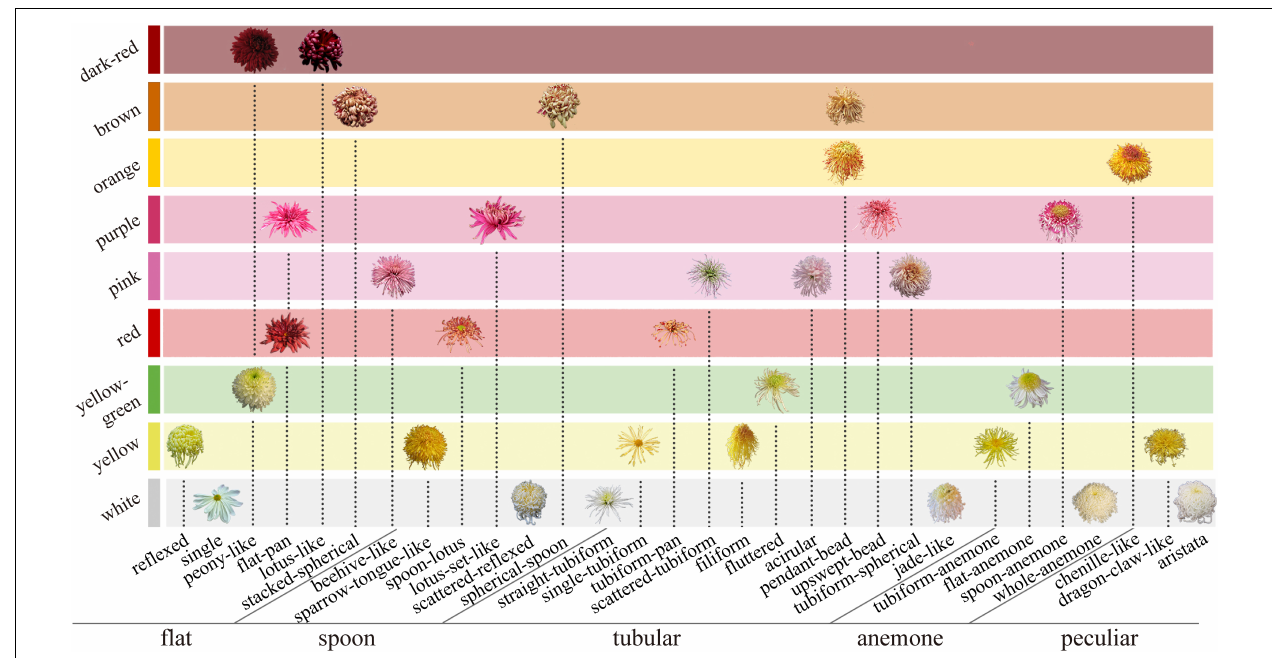
FIGURE 1 | Classification system of large-flowered chrysanthemum based on flower color, petal type, and flower type.